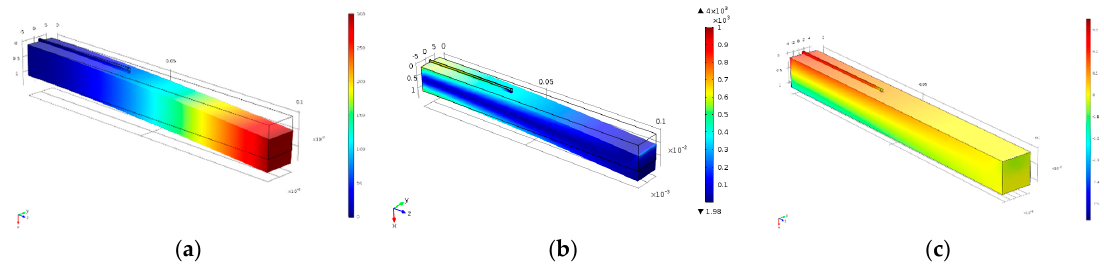
Figure 11. Contour plots of the cantilever beam. ( a ) Displacement; ( b ) Von Mises Stresses; ( c ) Strain distribution.